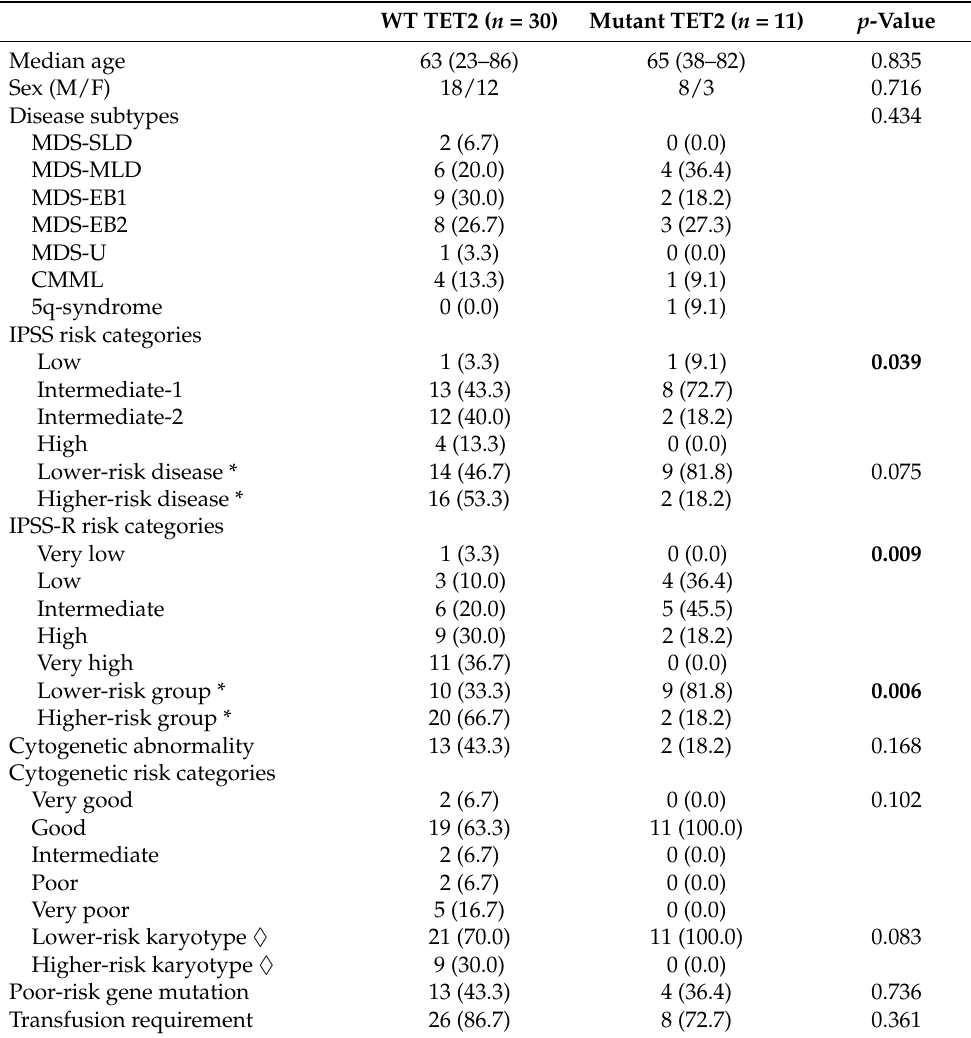
Table 1. Baseline characteristics according to TET2 mutation status.